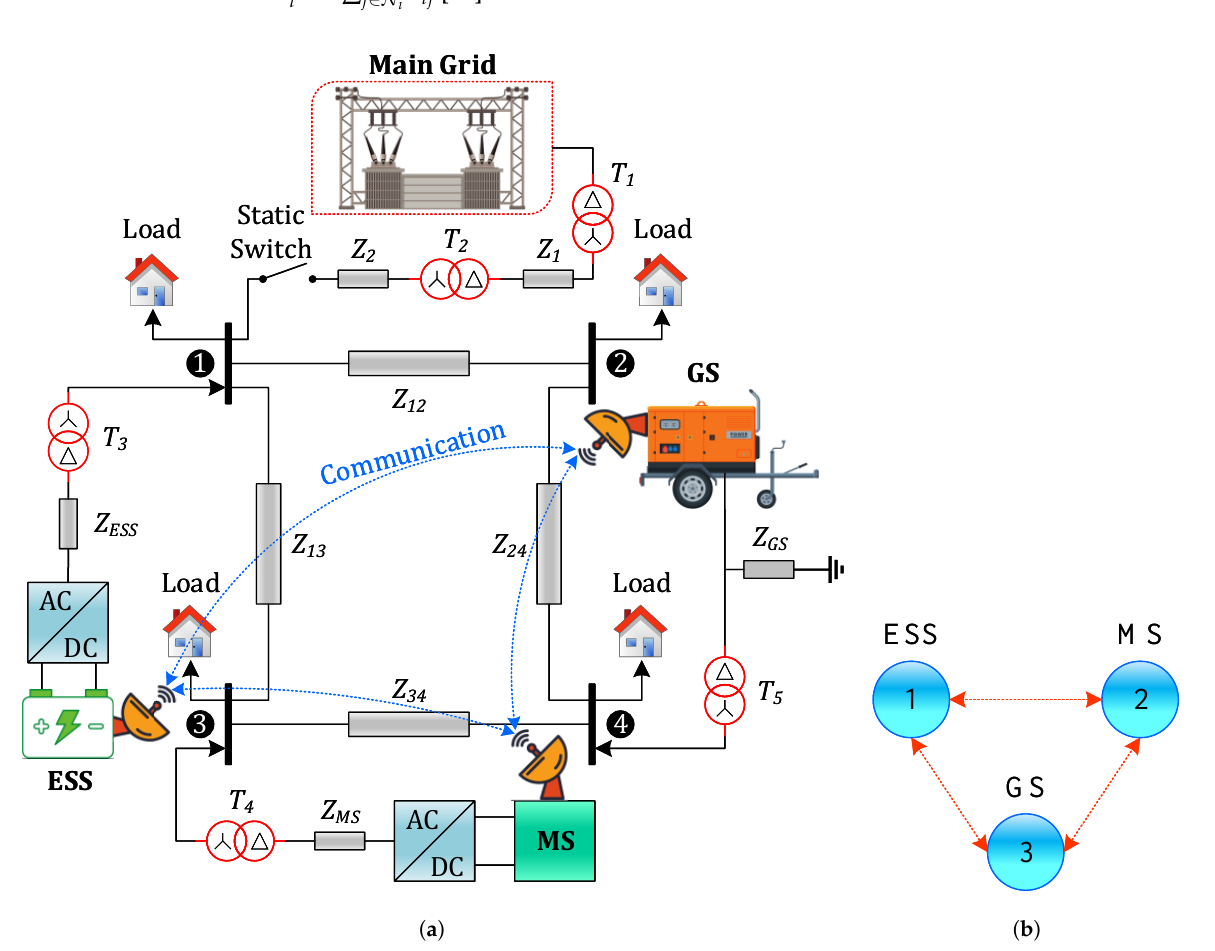
Figure 1. Microgrid simulation testbed and undirected communication graph between DGUs. ( a ) Microgrid simulation testbed.; ( b ) Communication